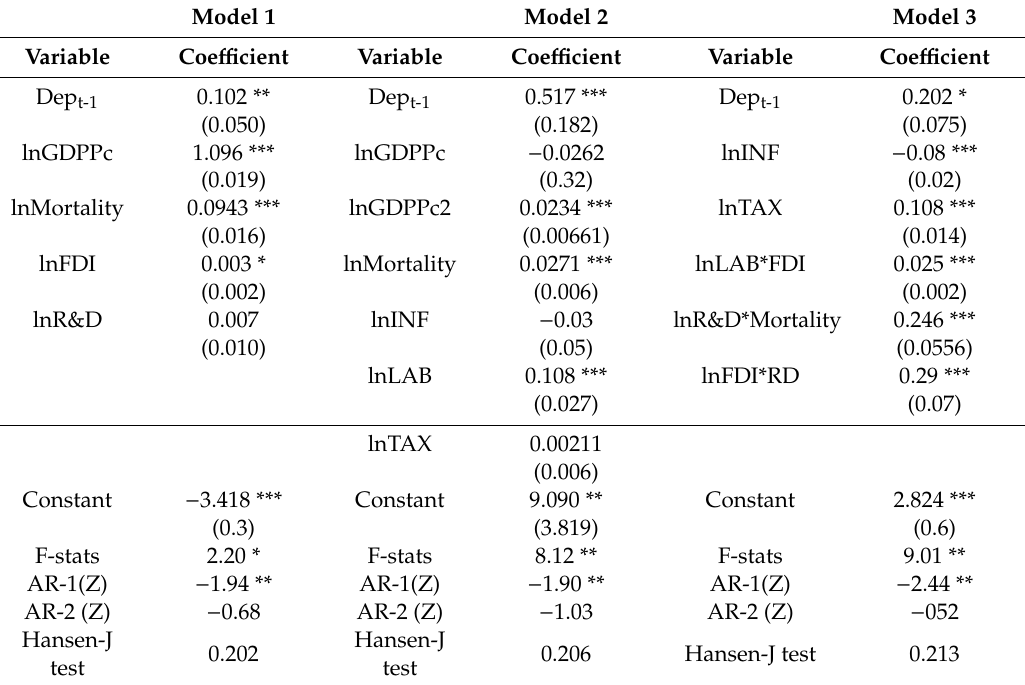
Table 3. Panel results for the generalized method of moments